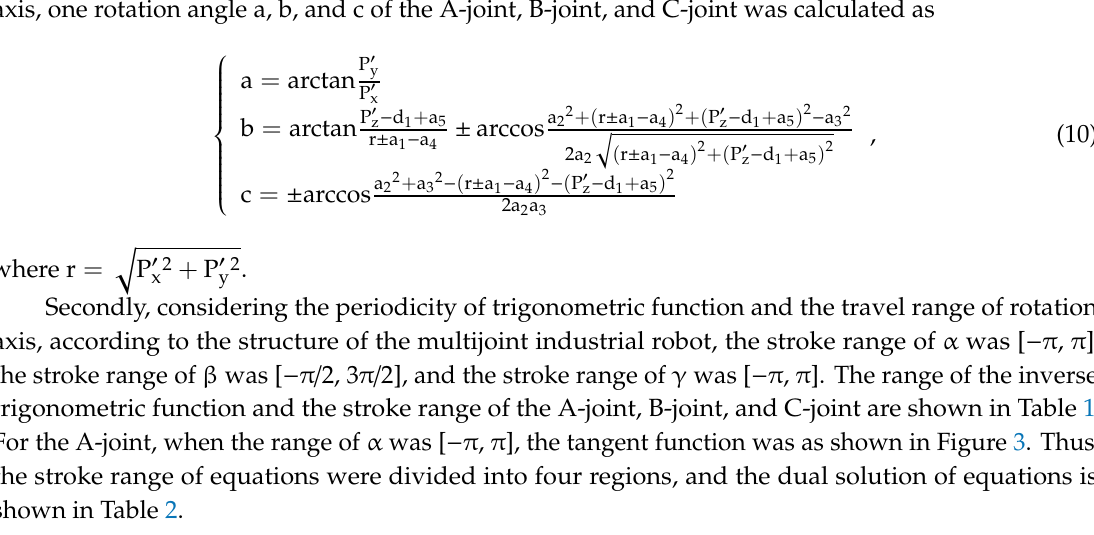
Table 1. The range of inverse trigonometric functions and the stroke of rotation axes. Solution of Rotation Angles Range of Inverse Trigonometric Functions Stroke of A-Joint, B-Joint, or C-Joint a = arctan ( P (cid:48) y /P (cid:48) x ) [ − π /2, π /2 ] [ − π , π ]